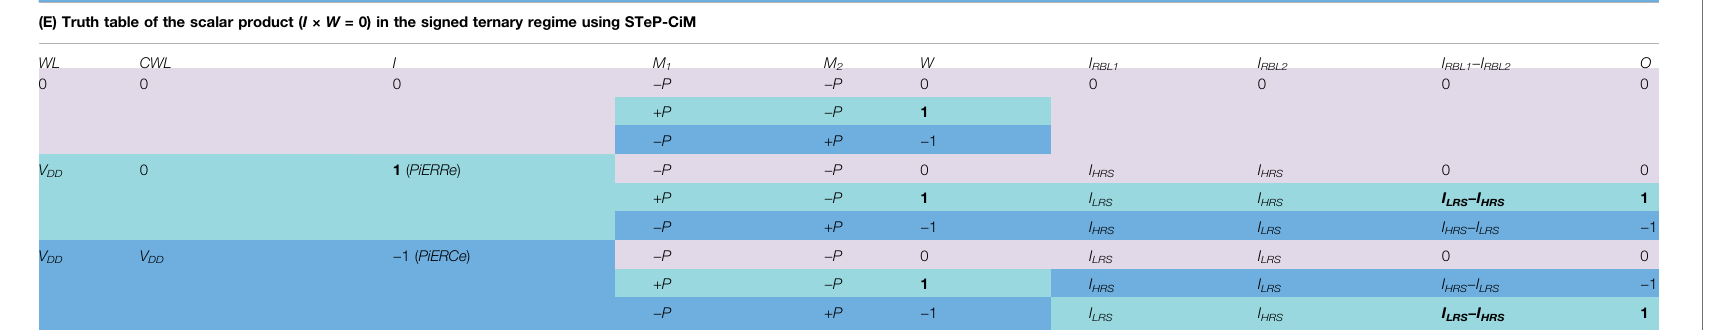
(E) Truth table of the scalar product ( I × W = 0) in the signed ternary regime using STeP-CiM